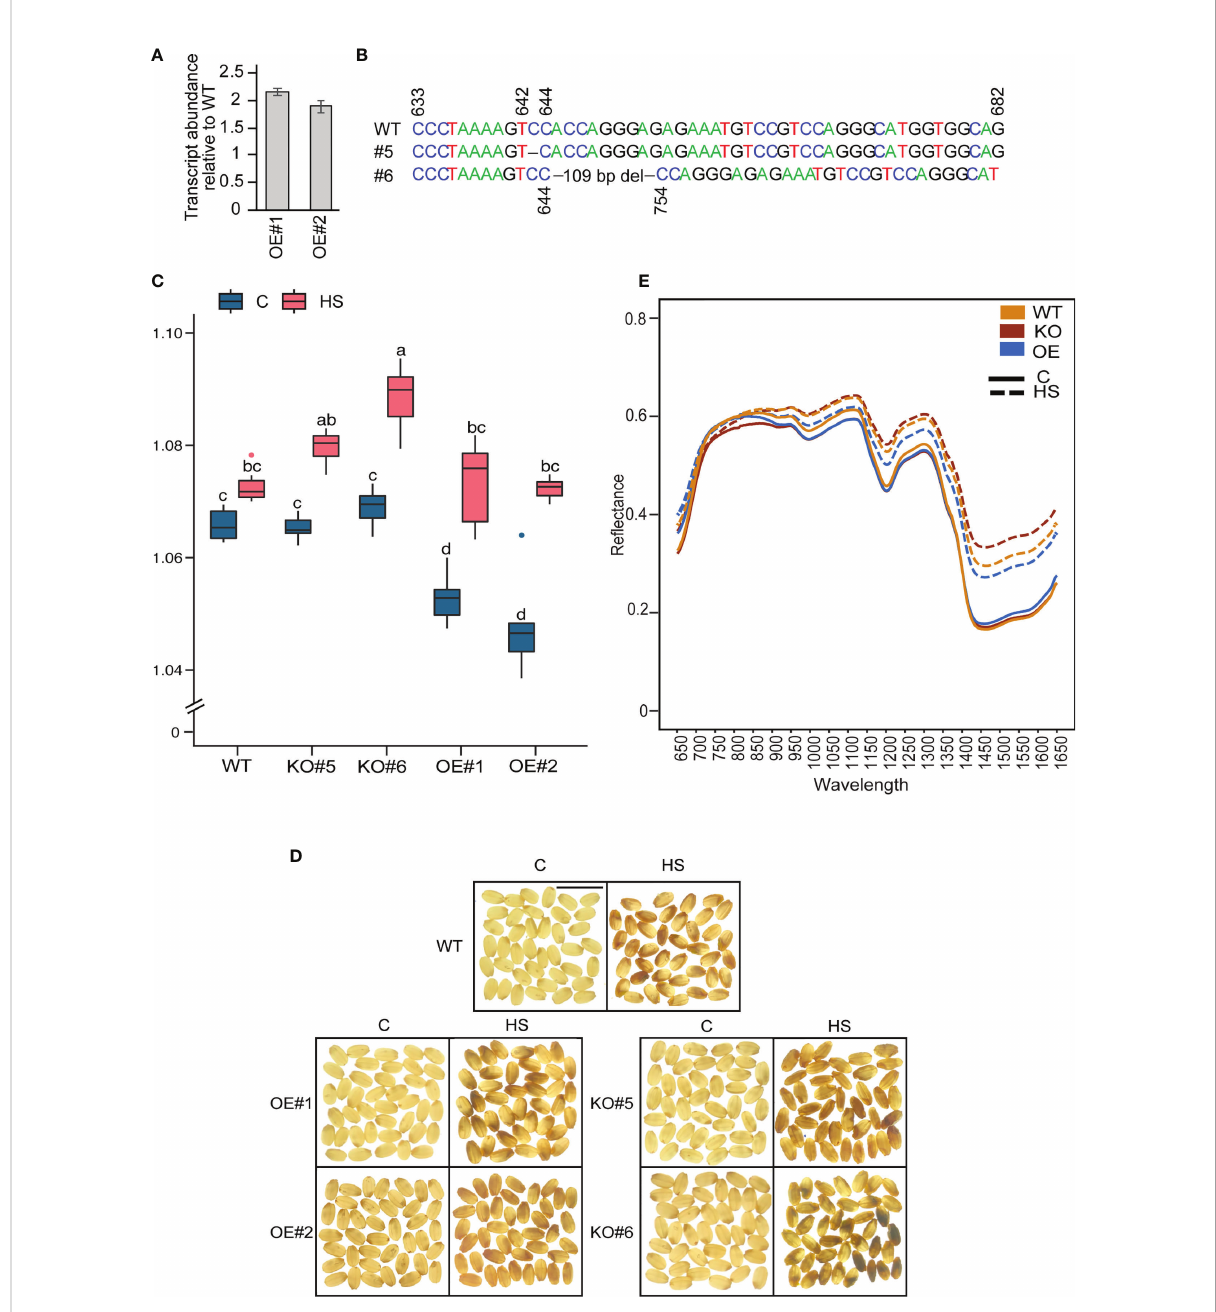
FIGURE 4 Characterization of the function of chalky grain 5 ( OsCG5 ) in grain chalkiness using CRISPR-Cas9 knockout (KO) and Overexpression (OE) lines. (A) RT-PCR assay showing higher transcript abundance of OsCG5 in OE lines relative to WT rice (cv. Kitaake). (B) Positions of Cas9 deletions in KO#5 and KO#6 lines (1 bp and 109 bp, respectively). (C) Distribution of the ratio of grain R and G pixel intensity values in WT, KO and OE genotypes under control and heat stress (HS). The signi fi cance was estimated using two-way ANOVA. N = 7-8 plants. Scale bar=1 cm. (D) Phenotypic difference in grain chalkiness for WT, KO and OE under control and HS. Scale bar=1 cm. (E) Hyperspectral re fl ectance of grains from WT, KO and OE genotypes at wavelength range 650-1650 nm under control and HS. C and HS indicate control and heat stress,